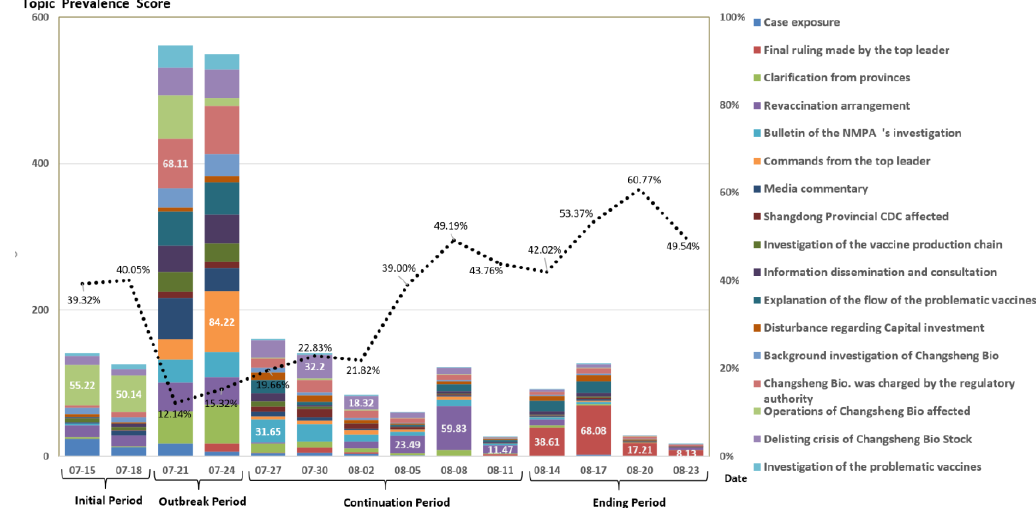
the highest prevalence topics at a certain time